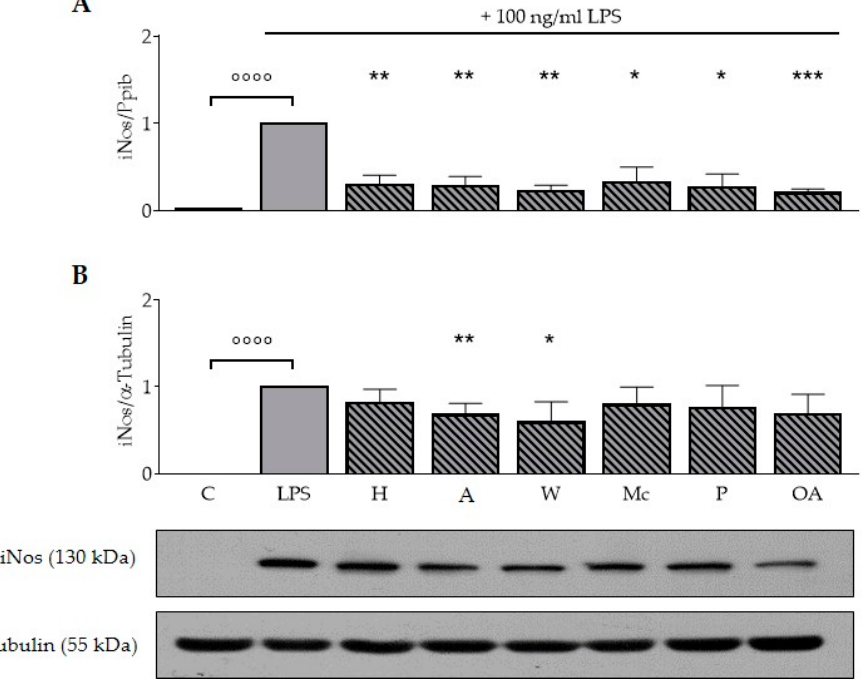
Figure 1. Oily nut extracts and oleic acid diminish lipopolysaccharide-induced expression of iNos mRNA and protein expression in murine RAW264.7 macrophages. Murine RAW264.7 macrophages were preincubated with medium, 200 µM oily nut extracts (ONE), or 200 µM oleic acid (OA) for 4 h followed by a coincubation of 100 ng/ml lipopolysaccharide (LPS) with medium, 200 µM ONEs, or 200 µM OA for additional 20 h. Untreated control samples were cultured with medium for 4 h plus 20 h; values of positive controls (LPS) were defined as 1. Expression of iNos mRNA (RT-qPCR) was normalized to Ppib mRNA expression, whereas iNos protein level (Western blot) was normalized to α -tubulin protein expression. ( A ) ONEs diminished LPS-induced iNos mRNA expression similar to OA. (B) Protein expression was also significantly reduced by the ONEs of almonds and walnuts. Western blots shown here are representative examples of the blots used for densitometry. Error bars display calculated mean expression levels of four independent biological replicates with one (A) or with two technical replicates ( B ). Abbreviations: A, almond; C, control; H, hazelnut; M, macadamia;